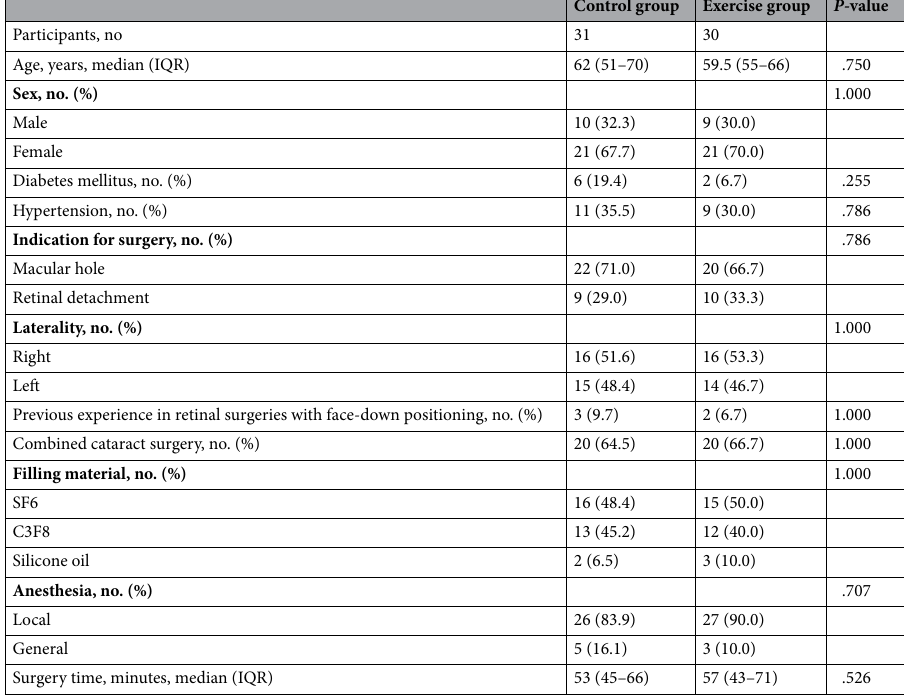
Table 1. Baseline characteristics of the study participants. The Mann–Whitney test and Fisher’s exact test were used for continuous and categorical variables, respectively. IQR, interquartile range; SF6, sulfur hexafluoride; C3F8, octafluoropropane.